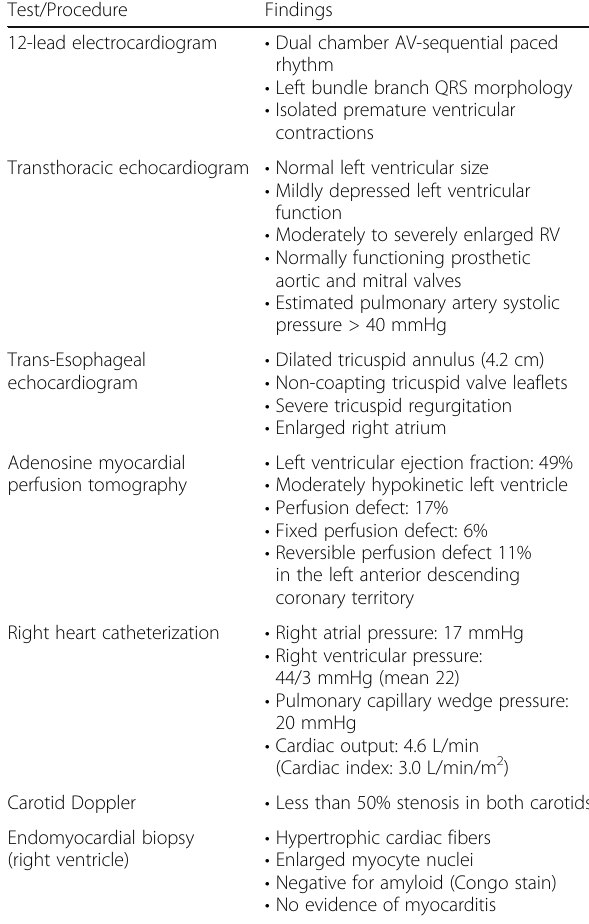
Table 2 Diagnostic tests results during last hospital admission Test/Procedure Findings 12-lead